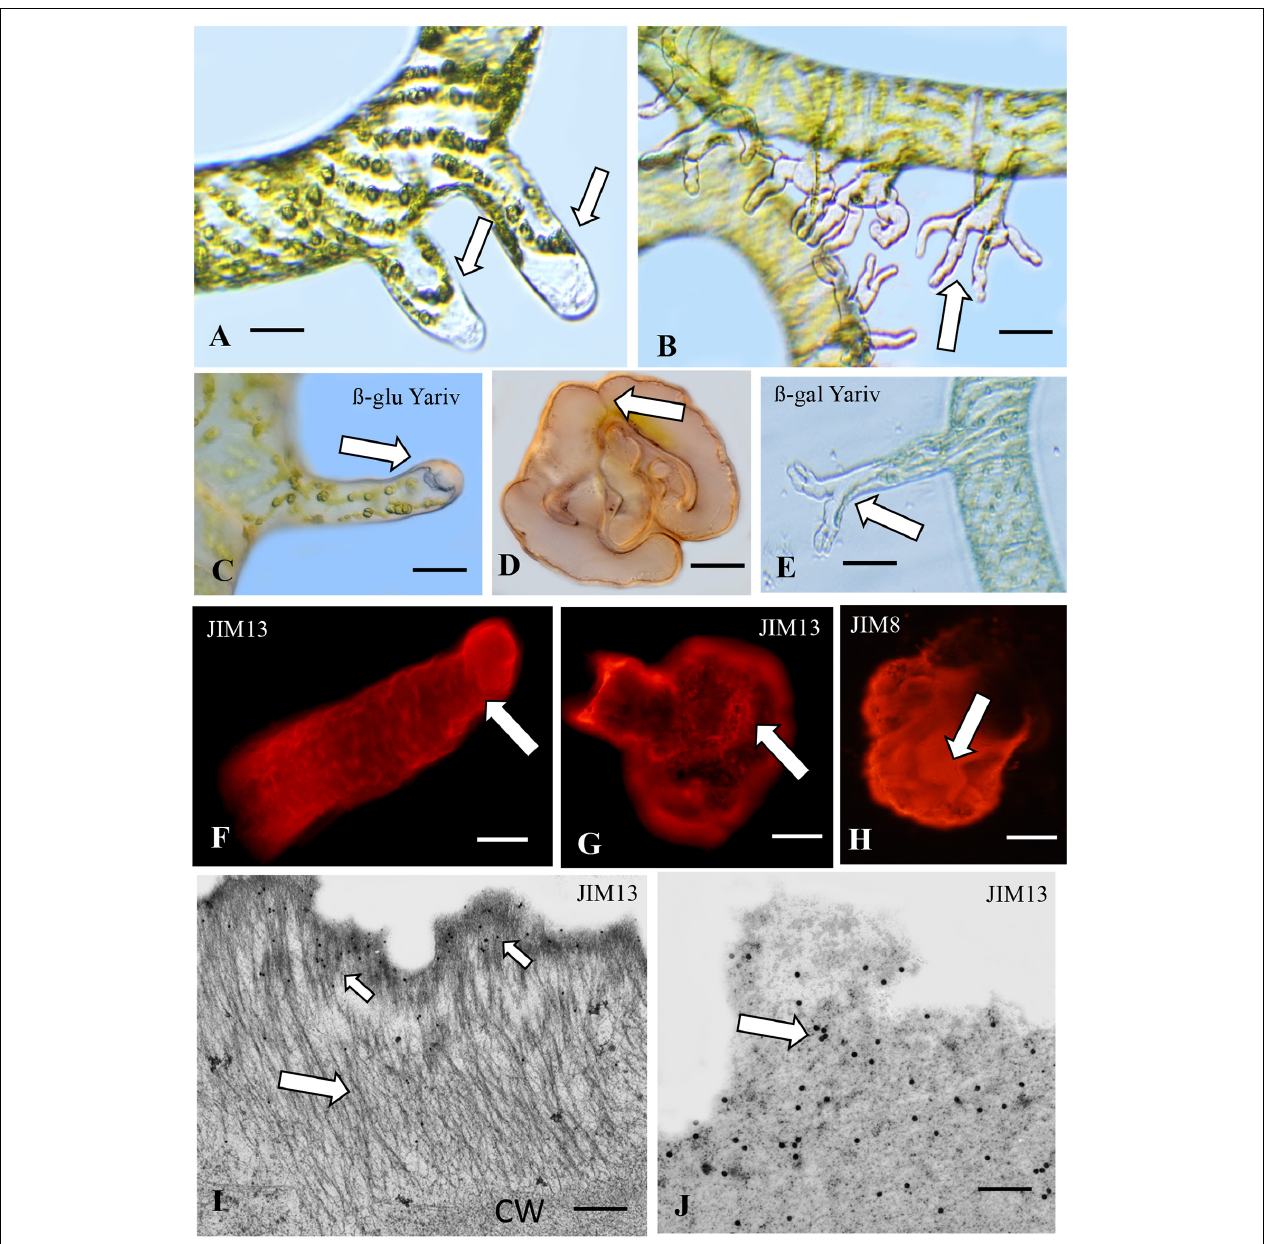
FIGURE 3 | Spirogyr a. (A) DIC image of young (24 h old) unbranched rhizoids (arrows) emerging from a wounded filament. Bar 48 µ m. (B) DIC image of mature (36 h old) branched rhizoids (arrow). Bar 65 µ m. (C) ß-glucosyl-Yariv labeling of the polar tip (arrow) of a young unbranched rhizoid. Bar 20 µ m. (D) Yariv reagent labeling of a mature branched rhizoid (arrow) at its attachment point on a glass substrate. Bar 50 µ m. (E) Yariv control. No labeling (arrow) with β -galactosyl Yariv. Bar 25 µ m. (F) JIM13 labeling of a sheath on the outer surface of a young unbranched rhizoid (arrow). (G) JIM13 labeling of the sheath surrounding mature branched rhizoids (arrow). Bar 40 µ m. (H) JIM8 labeling of the sheath surrounding mature branched rhizoids (arrow). Bar 50 µ m. (I) TEM image of the ECM of a young rhizoid. External to the cell wall (CW) emerges a fibrillar sheath (large arrow). Limited JIM13 labeling is apparent on the sheath surface (small arrows). (J) JIM13 labeling of the sheath of mature rhizoids (arrow). Bars ( I,J ) 600